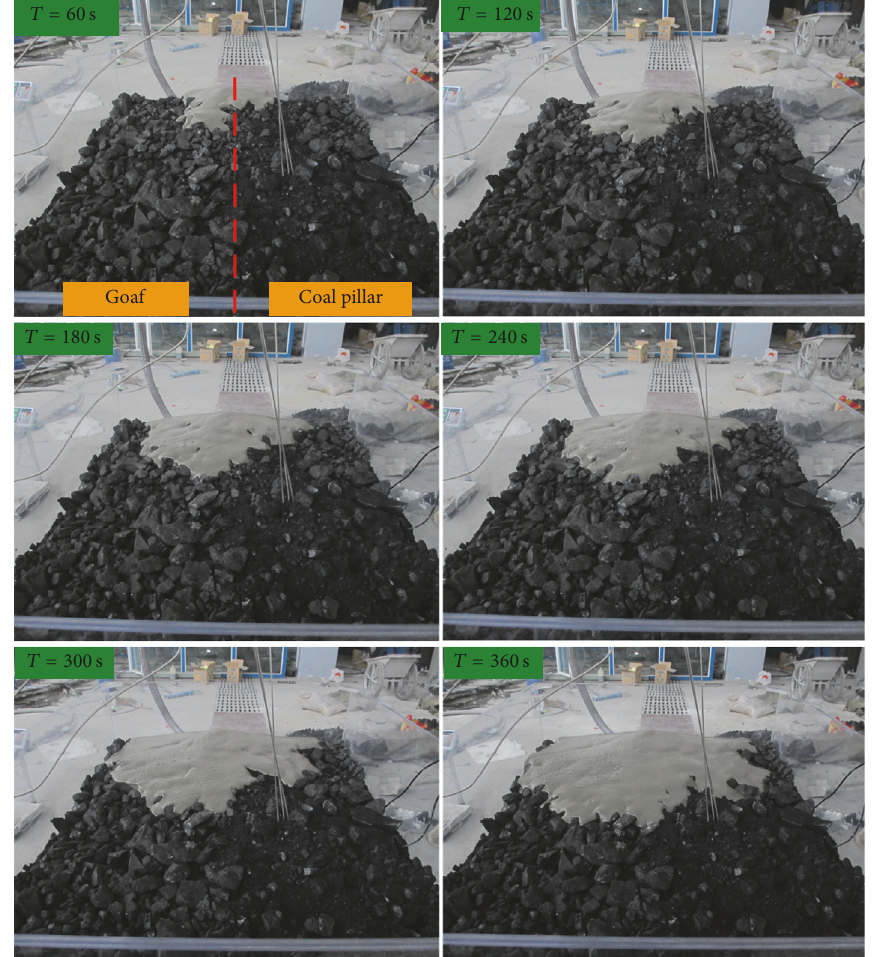
Figure 4: The penetration and diffusion form of the foam fluid in the 𝑋 - 𝑌